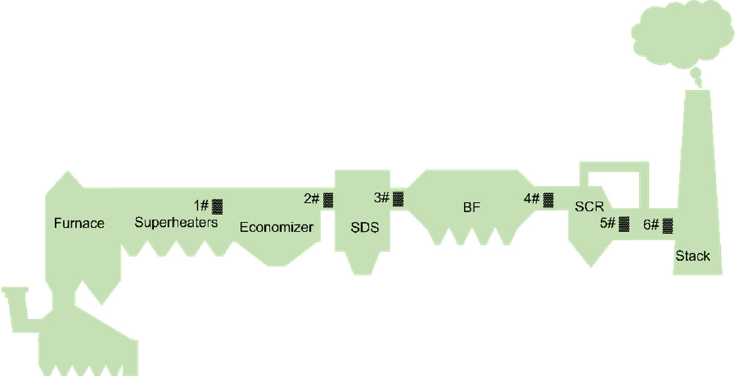
Figure 1. Systemic diagram of MSWI. 1# was located at the superheater outlet; 2# was located at the economizer outlet; 3# was located at SDS outlet; 4# was located at BF outlet; 5# was located at SCR outlet; 6# was located at stack inlet.